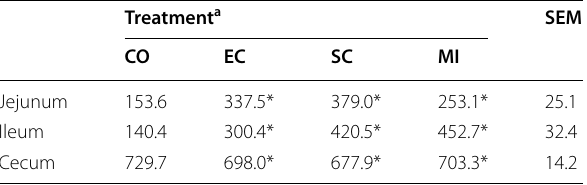
a CO (Control); basal diet only, EC; with EC12 (0.1 %, w /w),SC; with SCE (1.0 %, w /w), MI (Mix); with EC12 (0.005 %, w /w) and SCE (0.25 %, w /w). * Means within rows are significantly different (P < 0.05 vs. CO group)